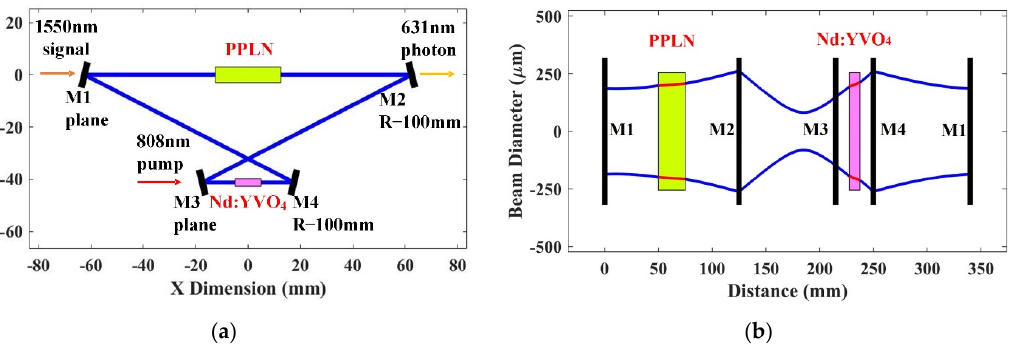
Figure 2. ( a ) The layout of the designed resonant cavity of the UPD, ( b ) the beam size evolution along the cavity.